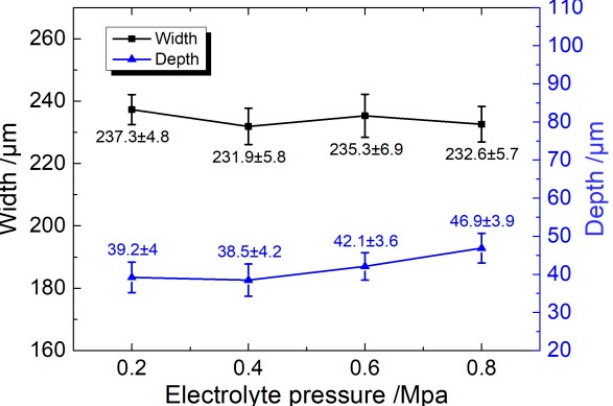
Figure 10. The dimension of micro-grooves generated with different electrolyte pressures ( U = 35 V, ε = 20%, f = 1 kHz, t on = 20 s).